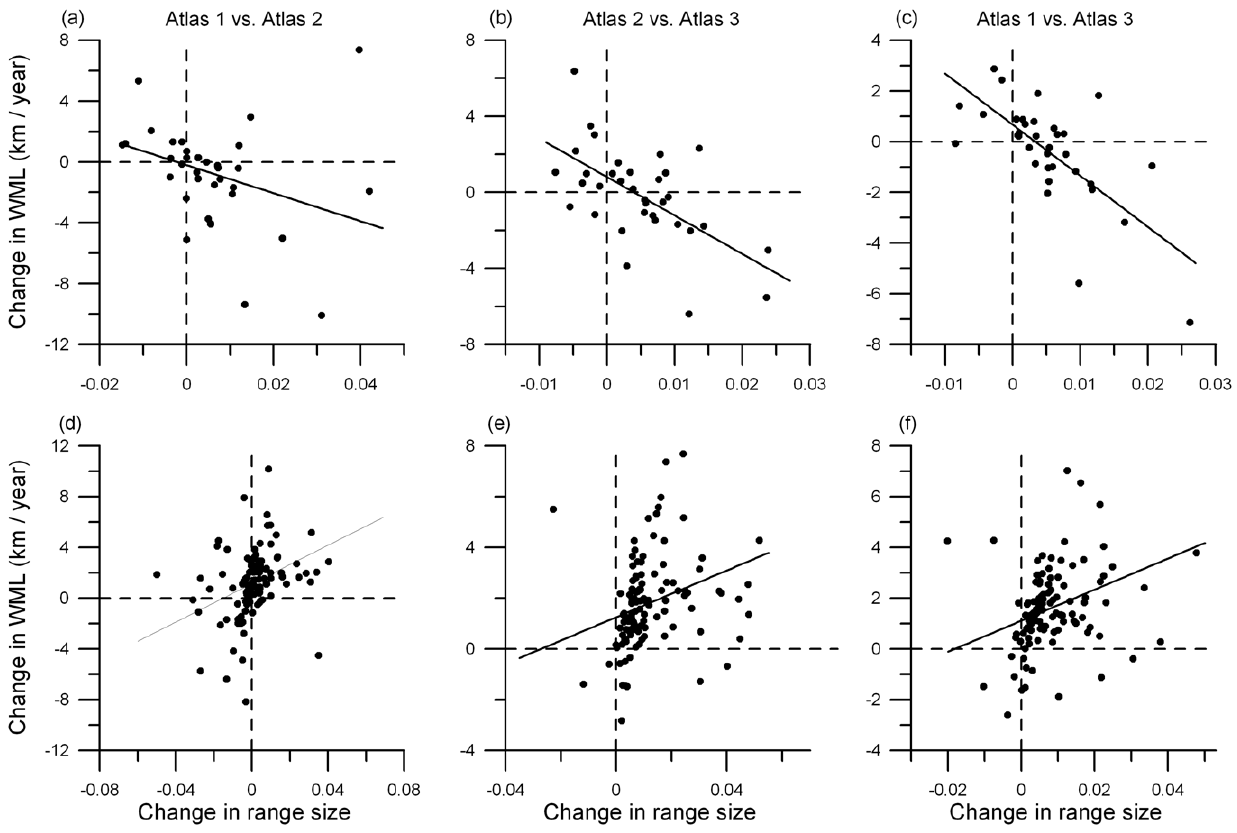
Figure 1. The shift in range margin of 114 European bird species (southern species) and 34 Arctic and northern boreal species (northern species). Plotted is the annual change in weighted mean latitude (in km) against the annual change in range size, as calculated from three atlases of Finnish breeding birds (Table 1). Results are displayed for three pairwise comparisons between the atlases for northern species (upper panels a,b, c) and southern species (lower panels d, e, f). Shift of the assemblage and other regression statistics of the linear regression (solid line) are given in Table 2. Note the differences in the scales across the panels. doi:10.1371/journal.pone.0043648.g001 PLOS ONE |